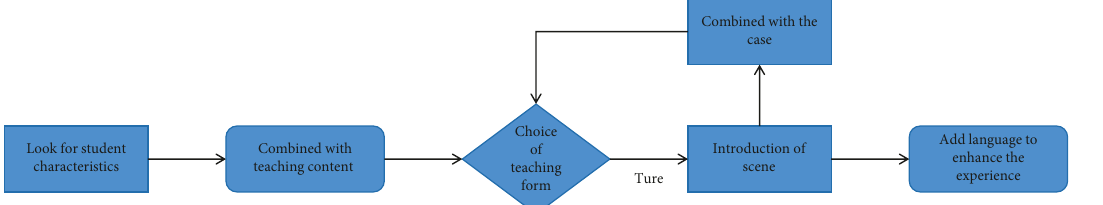
Figure 5: Situational teaching process.